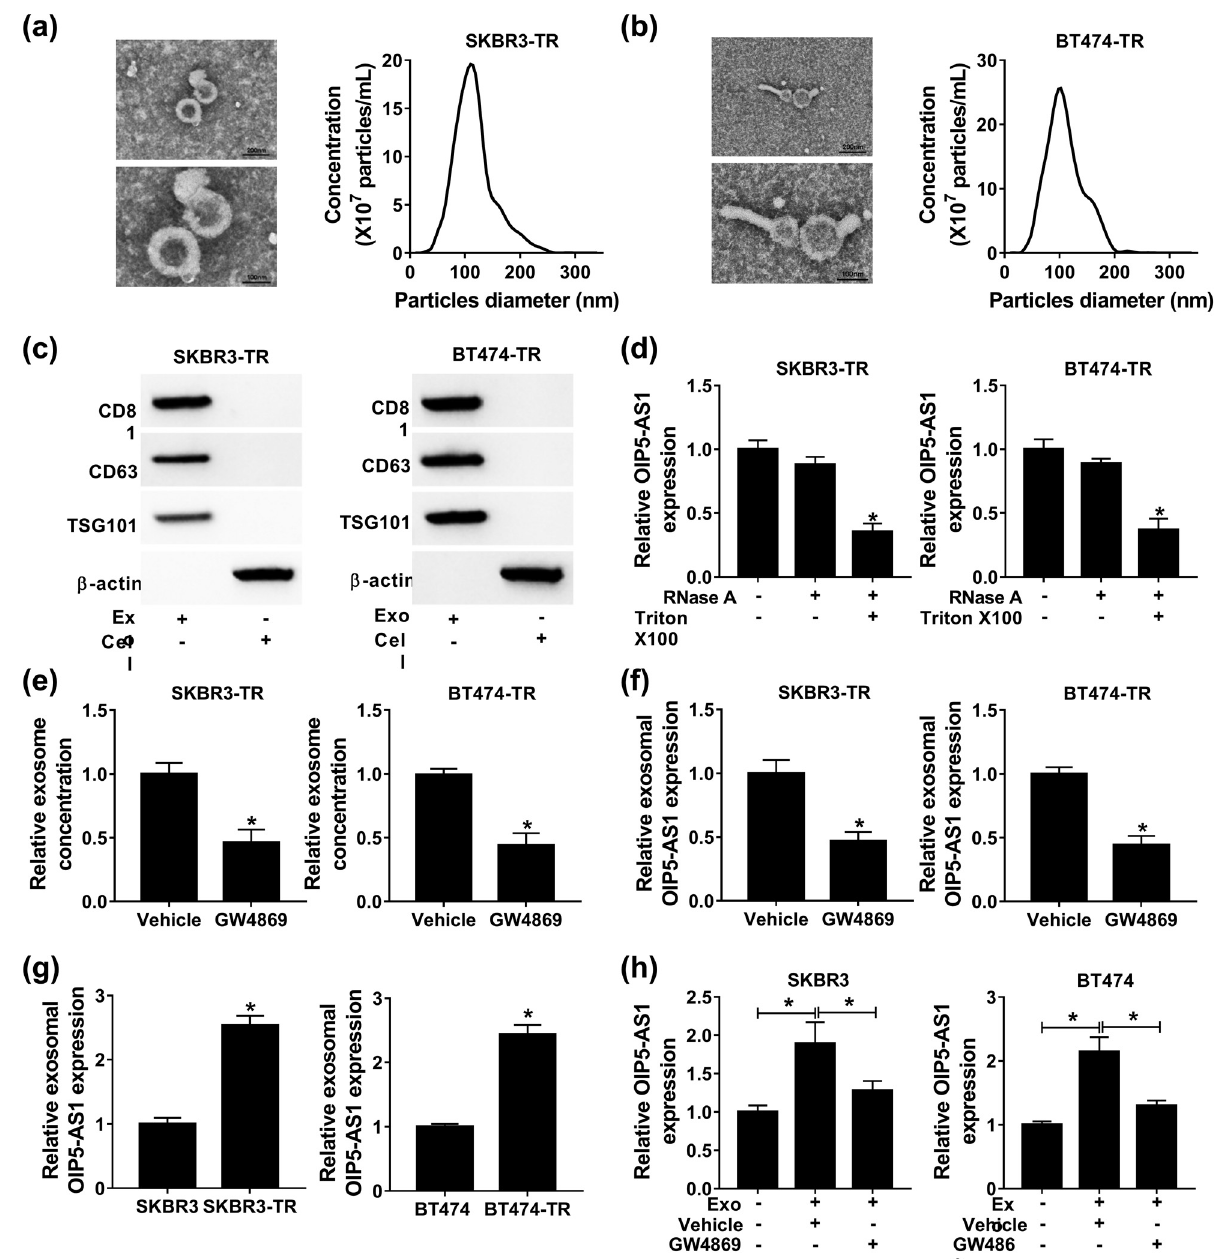
Figure 3: Exosomal OIP5 - AS1 derived from trastuzumab resistant cells can be absorbed by trastuzumab - sensitive cells in breast cancer. ( a and b ) The image of puri fi ed exosomes derived from SKBR3 - TR and BT474 - TR cells captured by TEM; size distribution of puri fi ed exosomes was analyzed by NTA. ( c ) Western blot analysis of exosomal marker CD81, CD63, and TSG101 in isolated exosomes. ( d ) qPCR analysis of OIP5 - AS1 expression in SKBR3 - TR and BT474 - TR cells following treatment with RNase alone or in combination with 0.1%